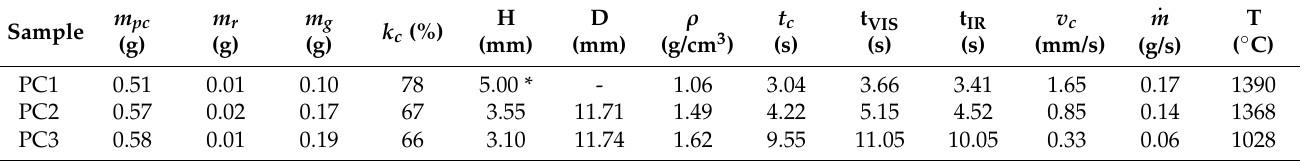
Table 2. The combustion rate and combustion flow for pyrotechnics sample.